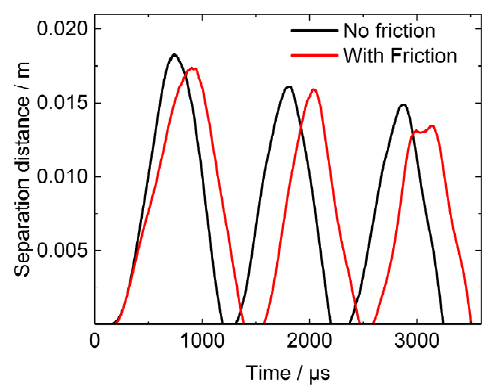
Figure 20. Evolution of separation distance between the tail of PBX1314 and projectile (The curve ‘No friction’ has been displayed in Figure 14b).